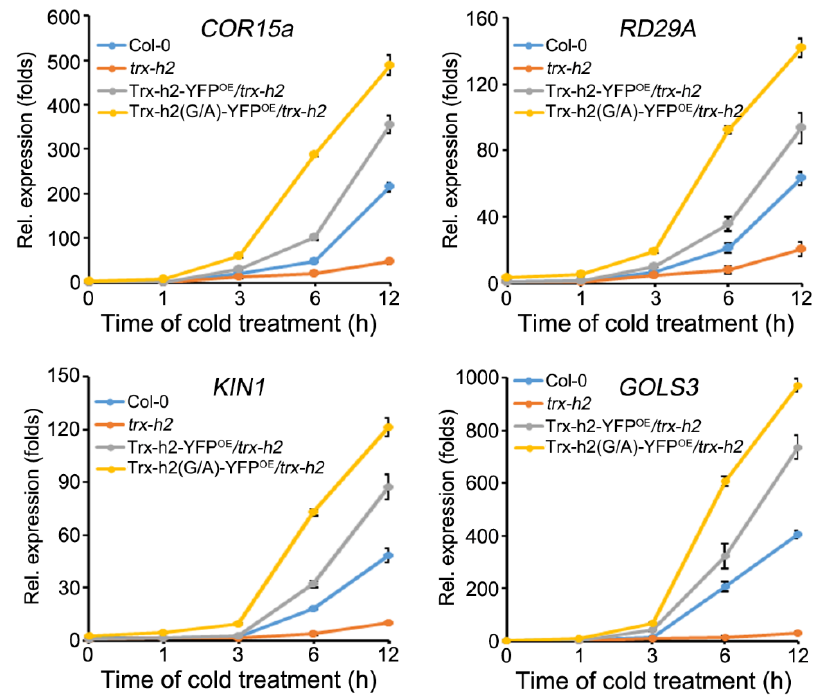
Figure 6. Comparison of the kinetics of Trx-h2- and Trx-h2(G/A)-mediated CORs expres- cold stress. Transcript levels of COR15a , RD29A , KIN1 , and GOLS3 were examined by qRT-PCR in sion under cold stress. Transcript levels of COR15a , RD29A , KIN1 , and GOLS3 were exam- ined by qRT-PCR in Col-0, trx-h2 , Trx-h2-YFP OE / trx-h2 , and Trx-h2(G/A)-YFP OE / trx-h2 Col-0, trx-h2 , Trx-h2-YFP OE / trx-h2 , and Trx-h2(G/A)-YFP OE / trx-h2 plants incubated at 4 ◦ C for the plants incubated at 4 °C for the indicated duration. Data represent mean ± s.e.m. ( n = 3 indicated duration. Data represent mean ± s.e.m. ( n = 3 biologically independent biologically independent samples).